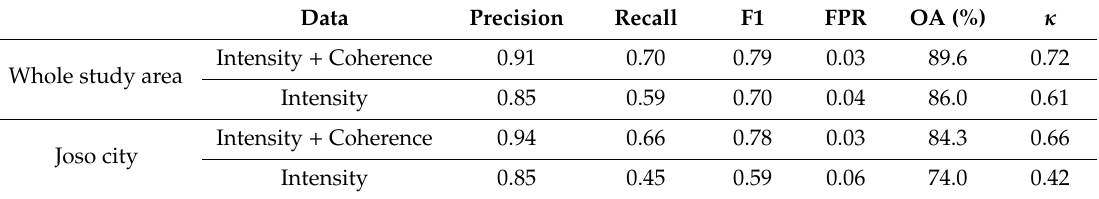
Figure 6. Flood extent maps of the Joso study area: ( a ) Binary flood extent based on the fusion of σ ° and γ ; ( b ) Flood category map of ( a ); ( c ) Binary flood extent based on σ ° alone; ( d ) Reference flood mask derived from high-resolution aerial photograph provided by the Geospatial Information Authority of Japan (GSI); ( e ) Flood posterior probability conditioned on σ °; ( f ) Flood posterior probability conditioned on γ ; ( g ) Zoom-in of the yellow box in ( a ); ( h ) Zoom-in of the yellow box in ( b ); ( i ) Zoom-in of the yellow box in ( c ); ( j ) Zoom-in of the yellow box in ( e ); ( k ) Zoom-in of the yellow box in ( f ).